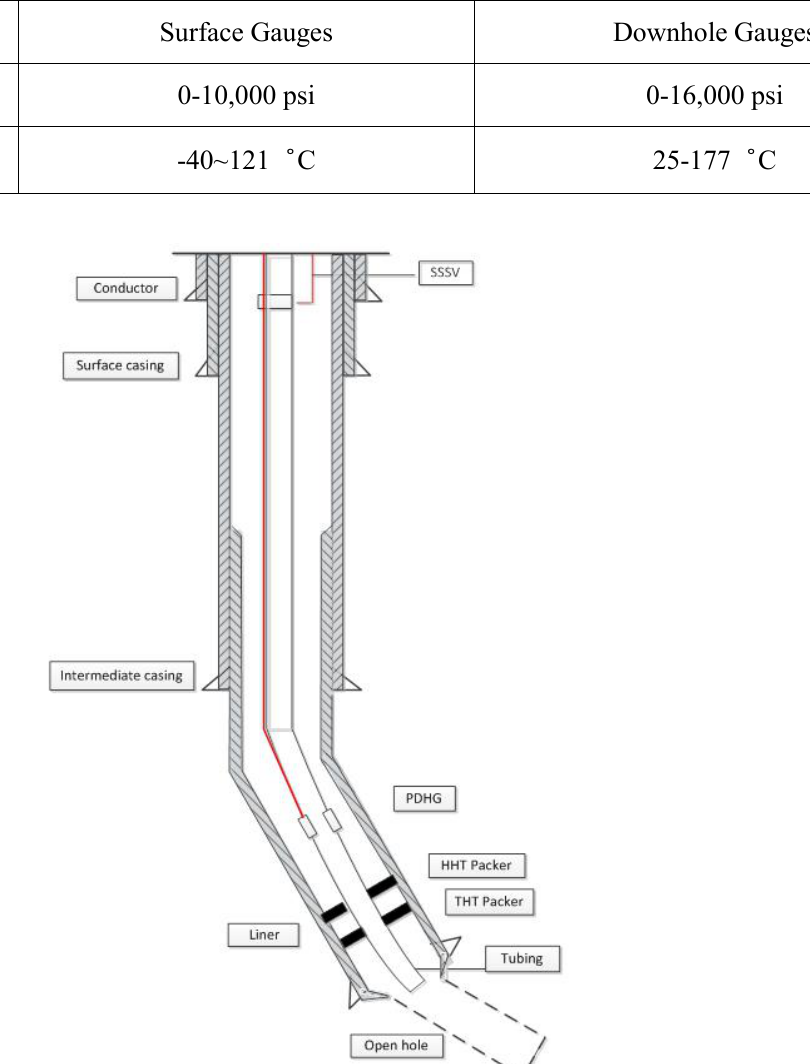
Table 1—Specifications of permanent gauges.